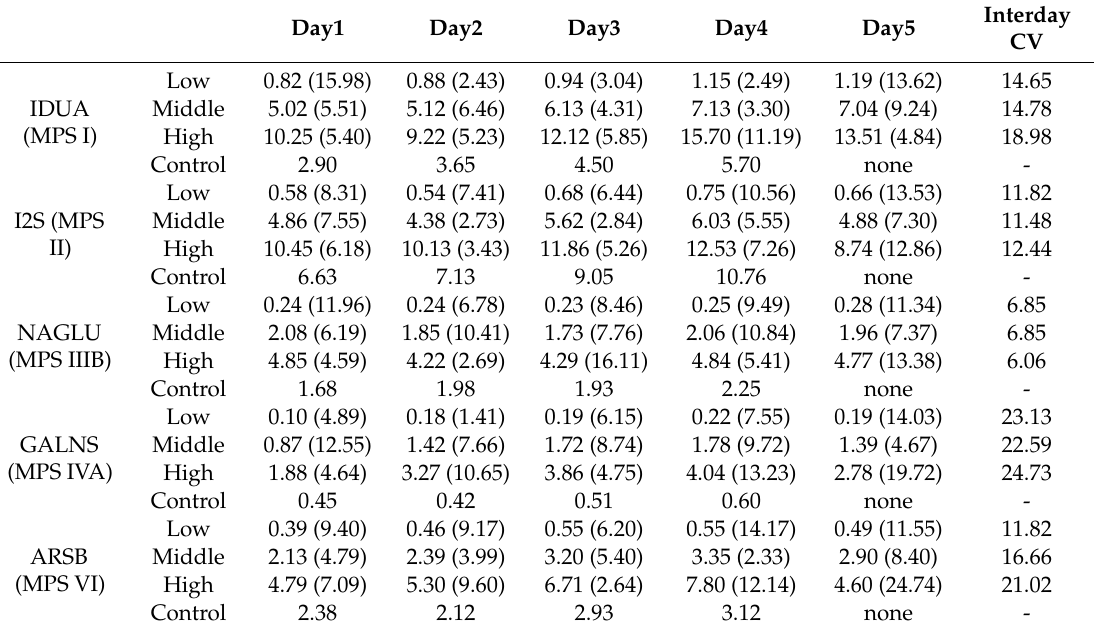
Table 1. Mean enzyme activity of QC and control ( µ M / h) and intraday and interday CV values (%). Day1 Day2 Day3 Day4 Day5